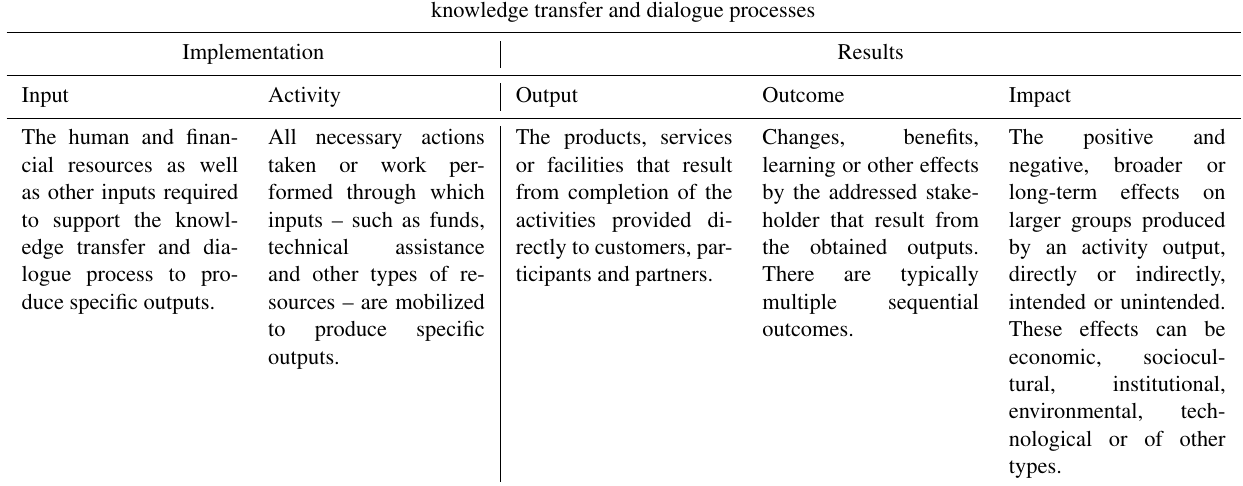
Table 1. Definitions of components for the result chain of the knowledge transfer and dialogue processes in the context of evaluation processes (e.g., Julian et al., 1995; OECD 2004; UNDG, 2010). knowledge transfer and dialogue processes